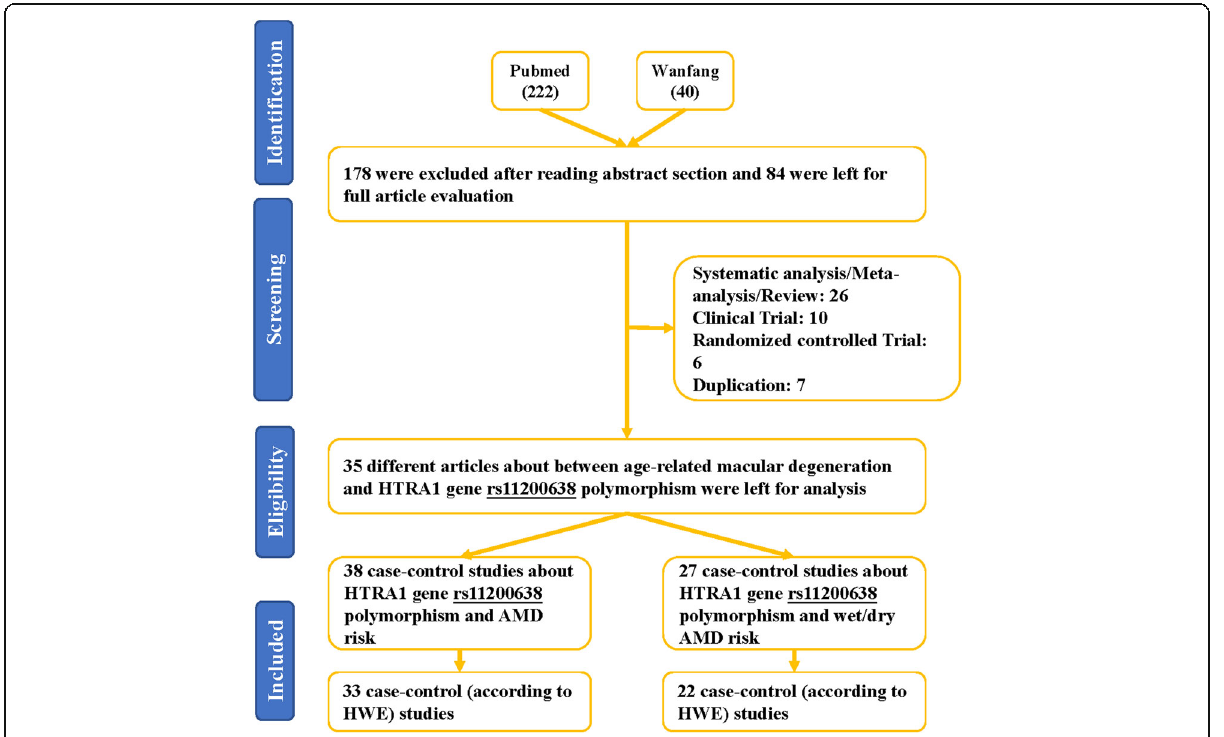
Fig. 1 Flowchart for the search strategy was used to identify associated studies for rs11200638 polymorphism and AMD